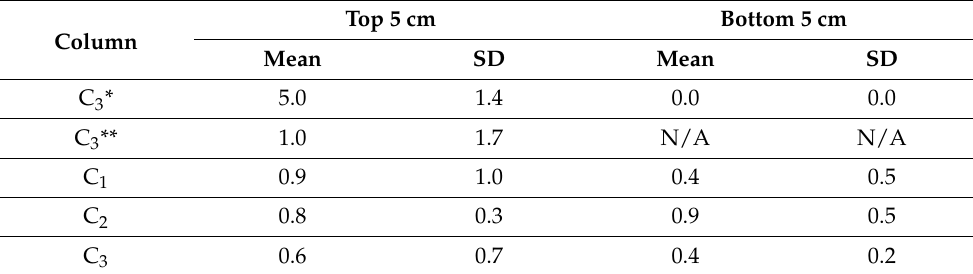
Table 3. Tire wear particles concentrations (TWP, in mg/g soil dw) in the 0–5 cm (Top 5 cm) and 35–40 cm (Bottom 5 cm) soil layers of bioretention columns C 1 –C 3 , following ZnCl 2 density separation of soil samples. In column C 3 , TWP concentrations were also determined without prior filtration nor density separation (C 3 *), and with filtration only (C 3 **). N/A: not